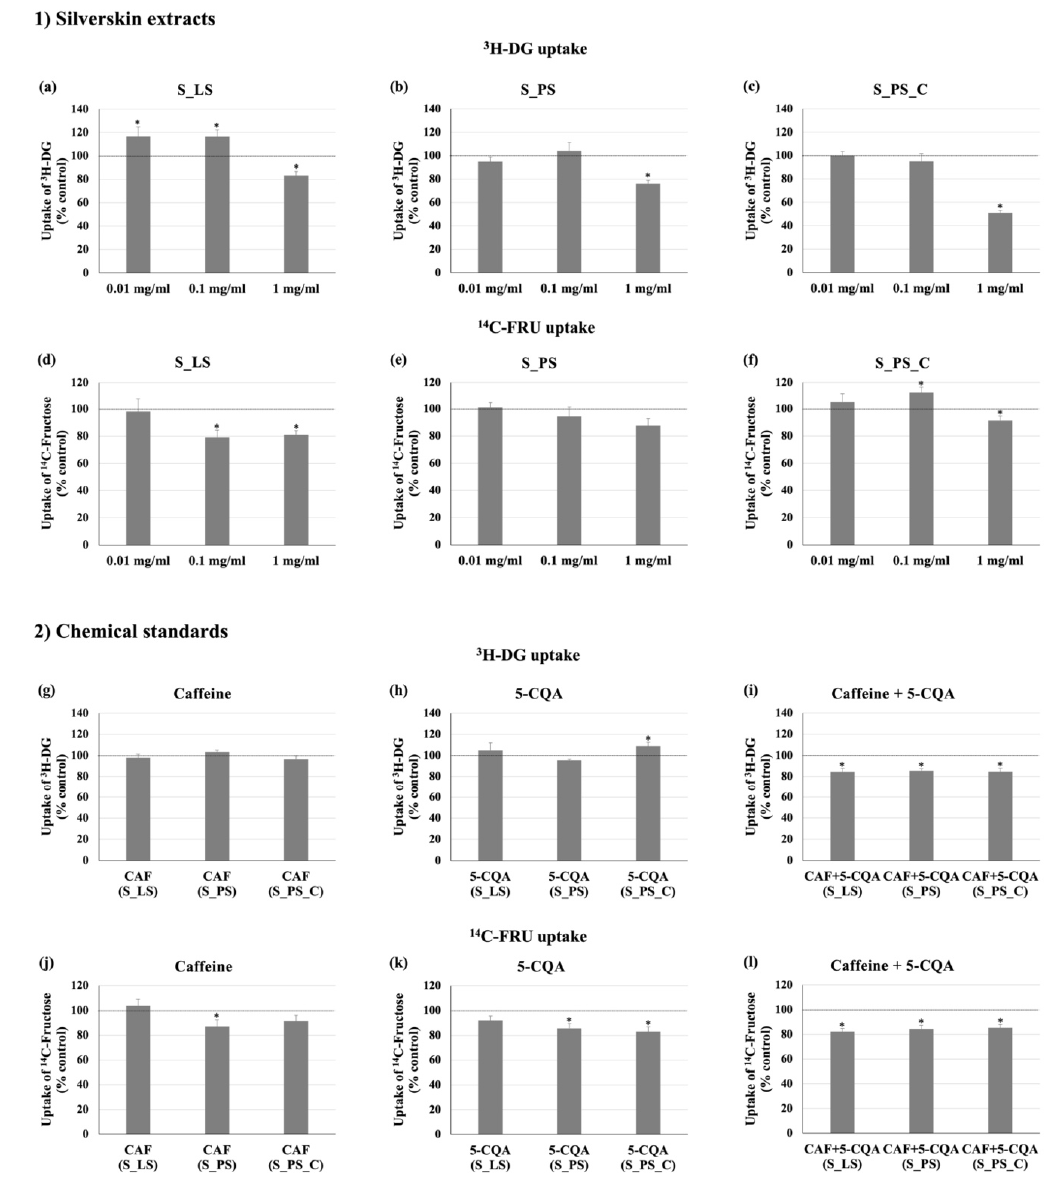
Figure 4. Effect of coffee silverskin freeze-dried extracts ( 1 ) and caffeine and 5-caffeoylquinic acid standards ( 2 ) on 3 H-DG and 14 C-FRU uptakes. Caco-2 cells were exposed to different concentrations of extracts S_LS, S_PS, and S_PS_C ( a – f ), in the presence of caffeine ( g , j ), 5-CQA ( h , k ), and caffeine plus 5-CQA ( i , l ), in the concentrations present in extracts S_LS, S_PS, and S_PS_C (g/L), or in the presence of the respective solvent (control) for 24 h. Uptake was measured by incubating cells at 37 °C with 10 nM 3 H-DG or 100 nM 14 C-FRU for 6 min. For each experiment, n ≥ 6. Results expressed as mean ± SEM. *, significantly different from control at p < 0.05.